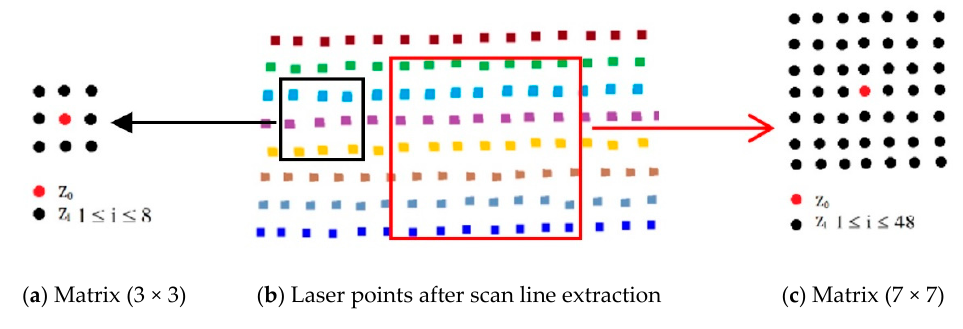
( c ) Matrix (3 × 3) Figure 2. Construction of the topological network; different colors represent different scan lines. Given that each scan line has a small number of laser points, the optimal adjacent point for each point can be easily found among the adjacent scan lines. This condition simplifies and accelerates construction of the topological network. The subsequent extraction process can then be handled easily based on this network. 3.2. Recognition of Ground Points The complexity of road infrastructure and the surrounding road corridor environment—trees, buildings, vehicles, and pedestrians—increases the difficulty in extracting ground and curb points. In this study, ground points were extracted using a moving window combined with the topological network. The moving window comprises the current laser point and its topological points. We used the moving window by considering the current point and its topological points as an approximate matrix (Figure 3) to achieve the extraction of ground points based on Equations (2) and (3). Equation (2) was